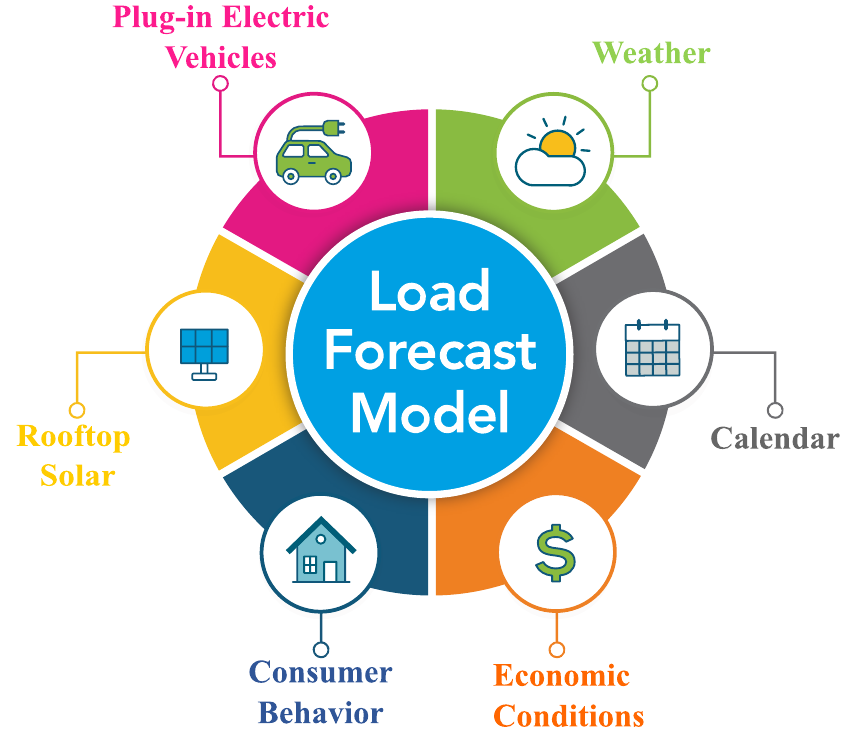
Figure 2. The factors that can affect the LF